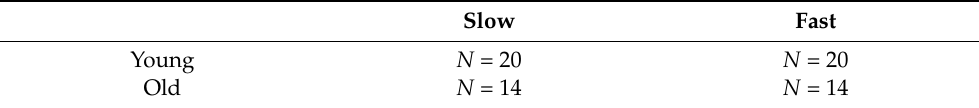
Table 1. Sample size for the mixed design ANOVA.